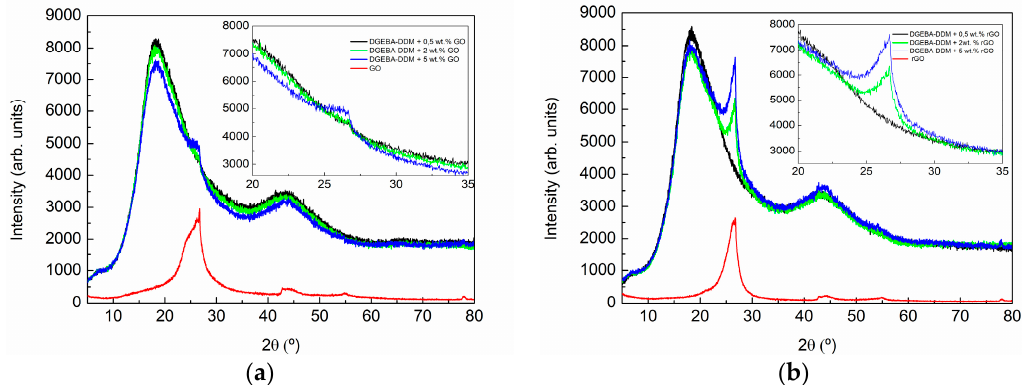
Figure 7. X-ray diffraction pattern of the composites with 0.5, 2, and 5 wt % of: ( a ) GO and ( b ) rGO. The right part shows a magnification of 20–35° 2 θ range of the patterns.